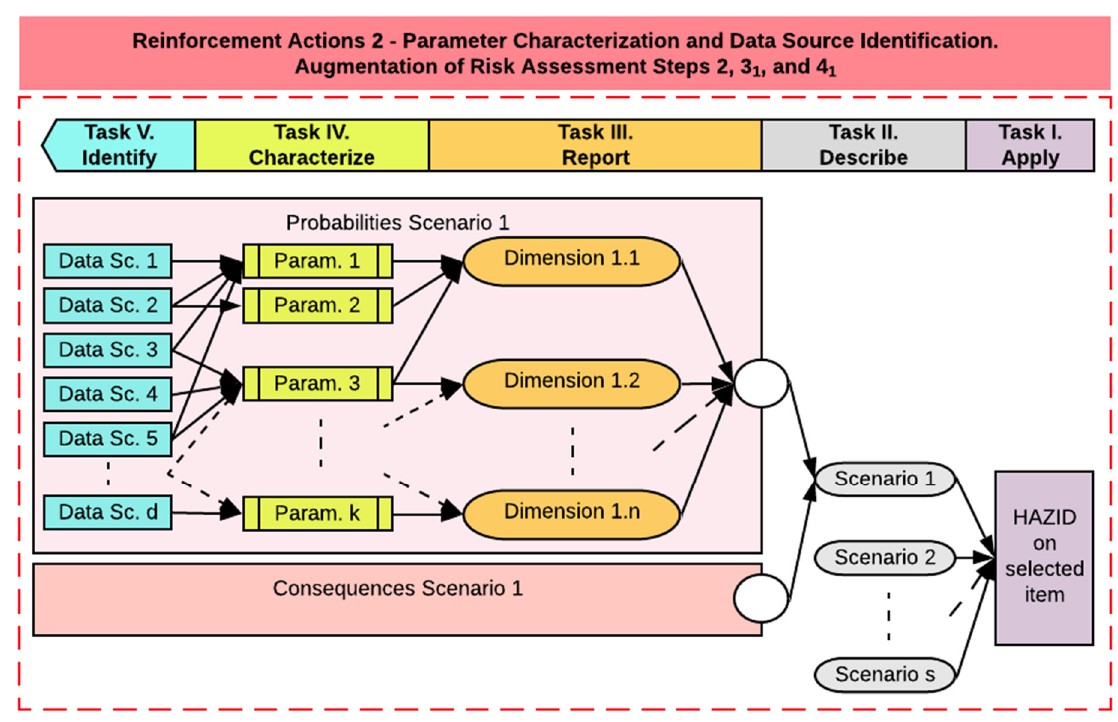
Figure 4. Identification of parameter characterization requirements and data sources potentially exploitable for the risk analysis.